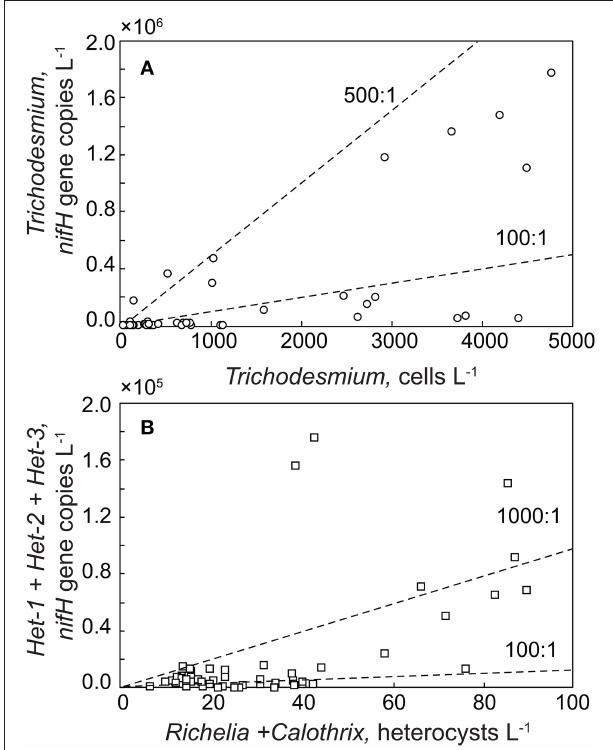
FIGURE 4 | Relationship between cell abundance and gene copies for (A) Trichodesmium and (B) heterocystous cyanobacteria collected in the upper 45m from Station ALOHA. Note that for heterocystous cells, microscopy-based counts only considered the heterocyst while there are known to be nifH copies in the vegetative cells as well. Isolines of gene copies: cell abundance ratios are noted as dashed